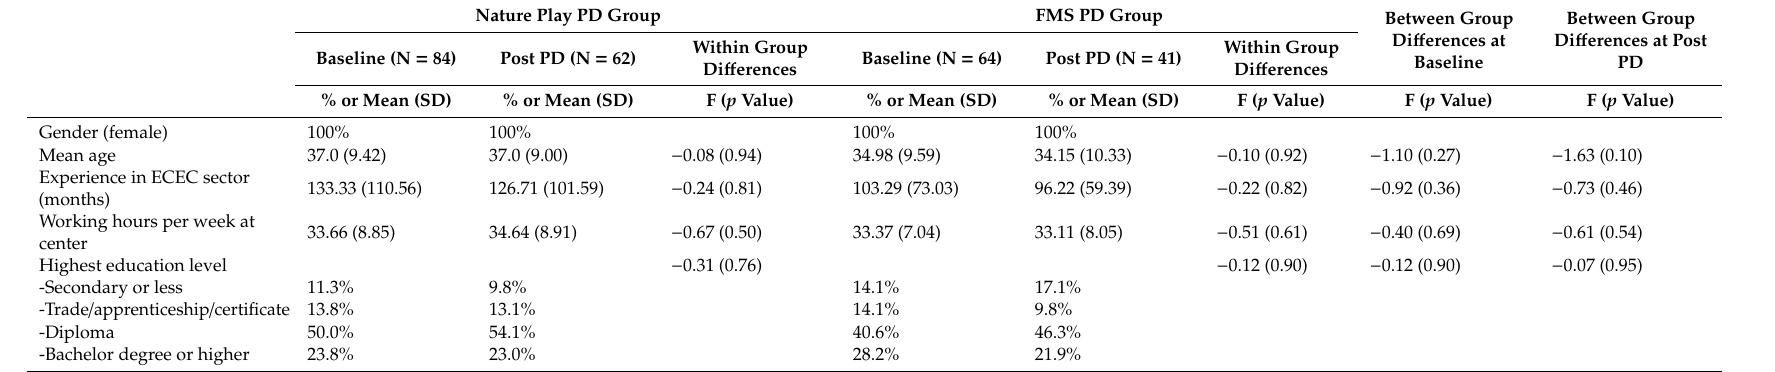
Table 1. Characteristics of study